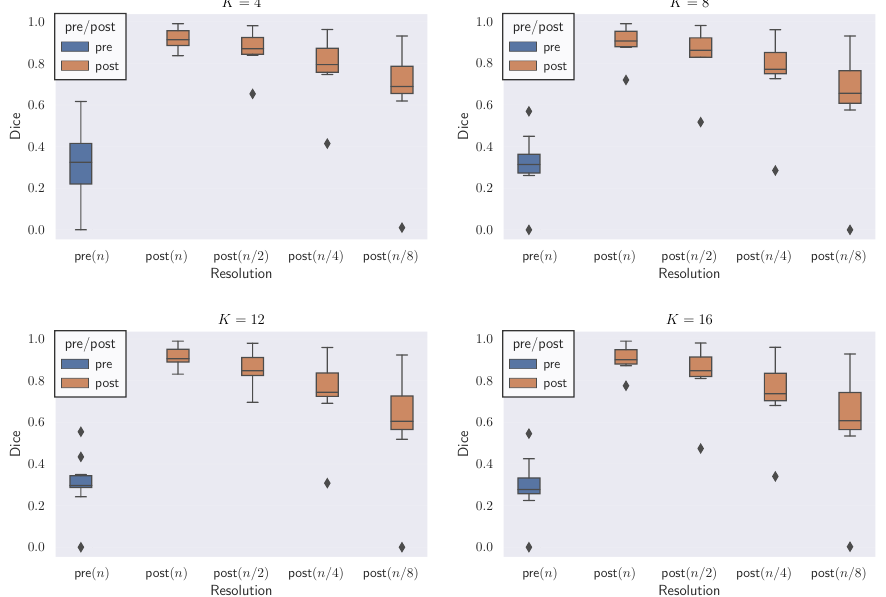
Figure 6. Experiment 2A: Quantitative results for the registration results corresponding to case 1. We show box plots of the Dice scores for the individual labels before and after registration for different resolutions. We consider the synthetic test problem SYN. This figure corresponds to the registration results reported in Table